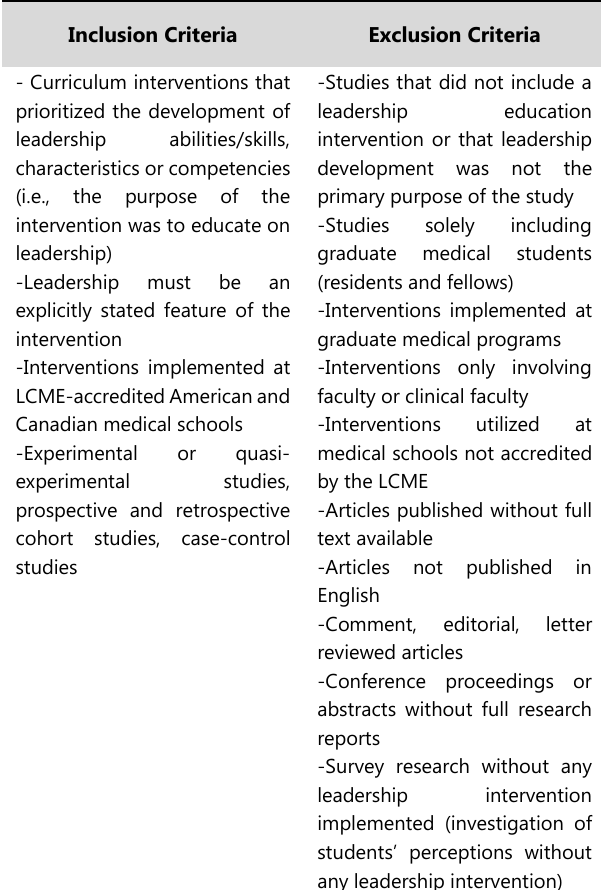
Table 1 . Inclusion and Exclusion Criteria.